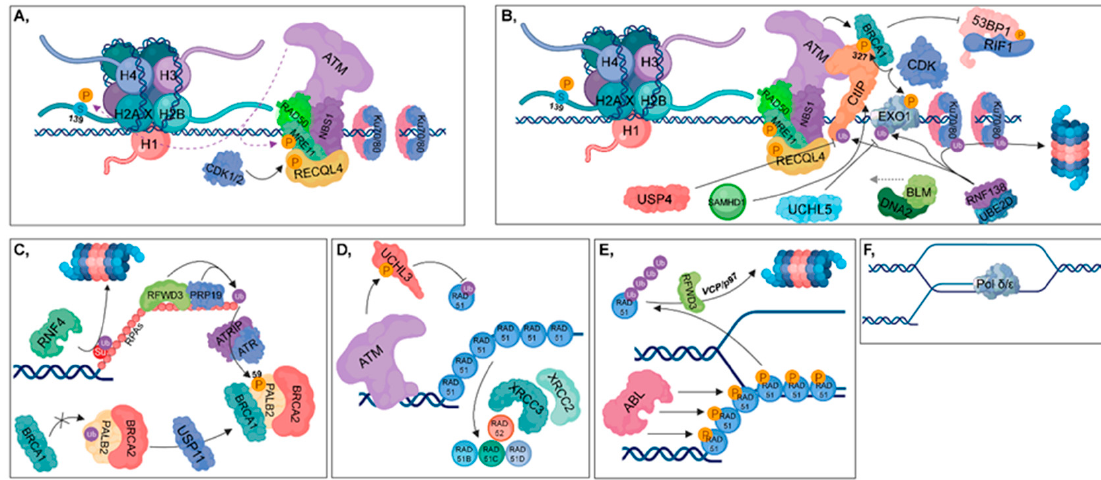
Figure 4. Homologous recombination (HR). ( A ) The RAD50-NBS1-MRE11 complex is recruited, resulting in the binding of ATM, which in turn phosphorylates MRE11, MDC1 and H2AX at Ser139. During the S and G2 phases, RECQL4 is phosphorylated by CDK1/2, contributing to its binding to MRE11, resulting in the activation of HR pathway. ( B ) CtIP (with the contribution of SAMHD1), BLM and DNA2 are recruited to the damaged site. MRE11 and CtIP take part in short-range end resection, while BLM and DNA2 are involved in long-range strand incision. CDKs phosphorylate CtIP and Exo1, while the RNF138-UBE2D complex is involved in their ubiquitylation. Deubiquitylation of CtIP and Exo1 is catalyzed by USP4 and UCHL5, respectively. The RNF138-UBE2D ubiquitylates Ku70/80 heterodimers, resulting in their proteasomal degradation. Phosphorylation of CtIP at S327 leads to the recruitment of BRCA1 (which is further stimulated by ATM) to that site, inhibiting 53BP1-RIF1